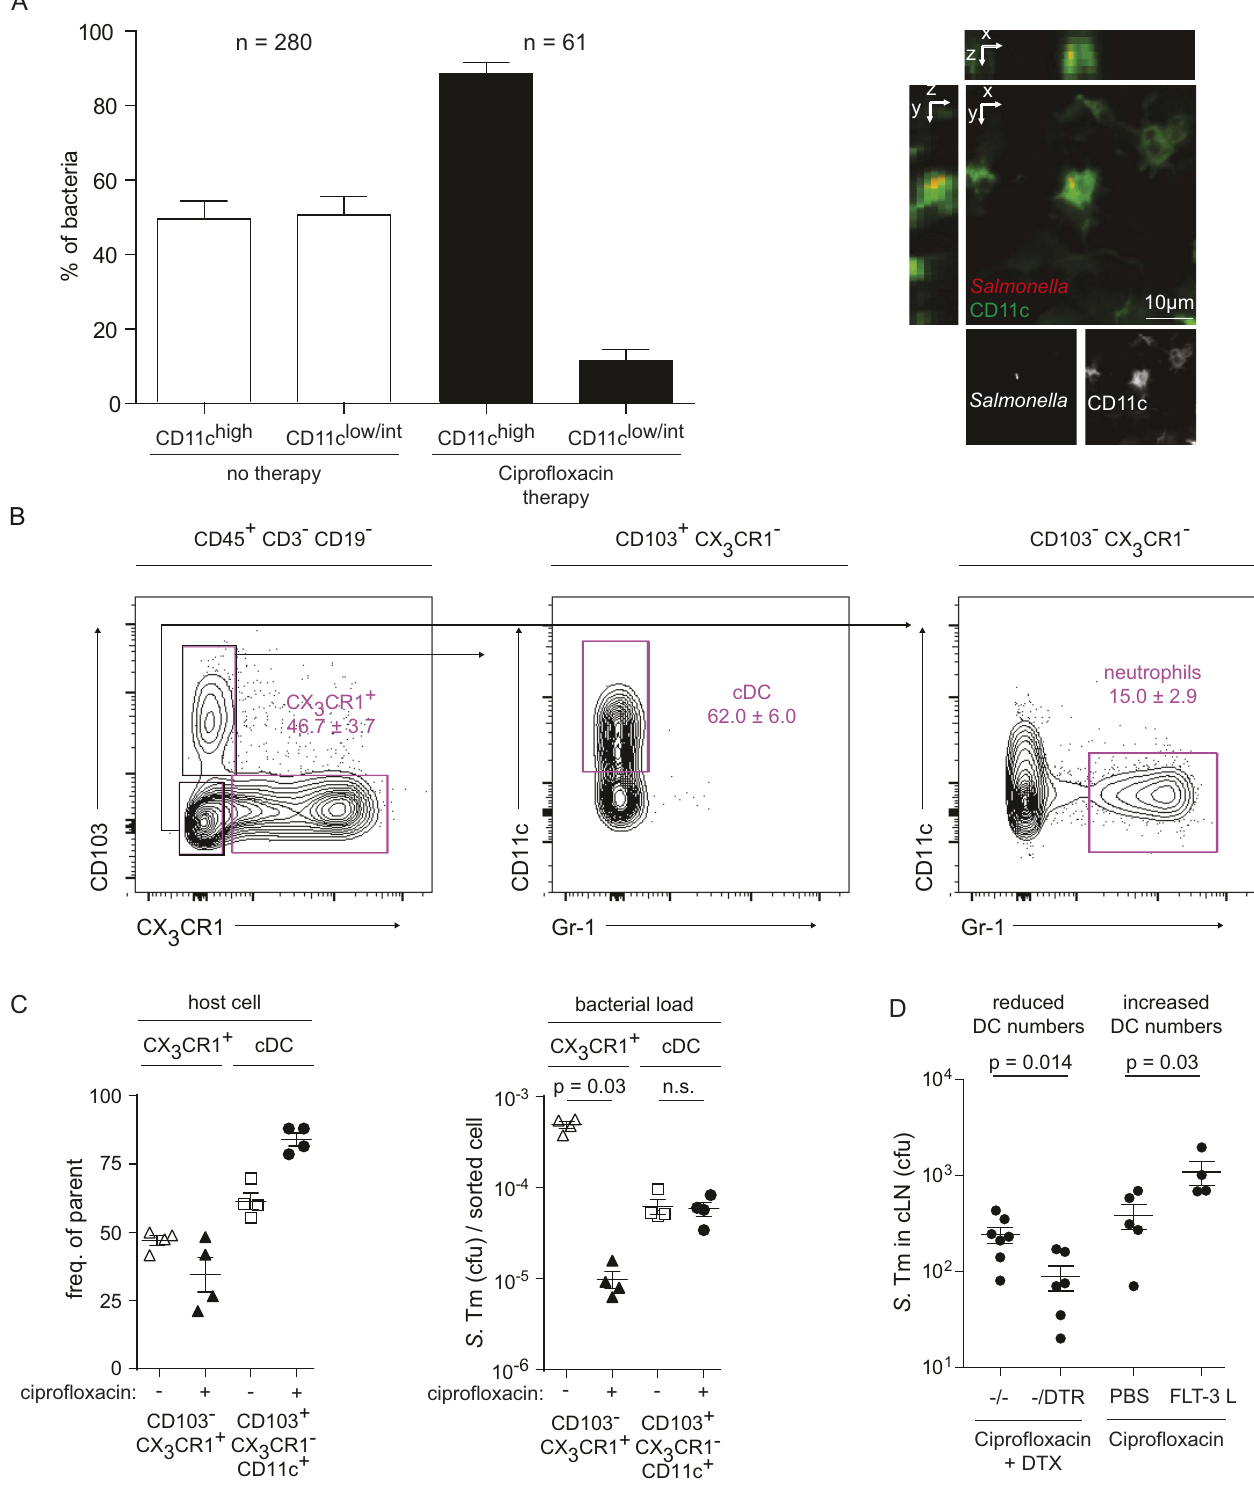
Figure 3. Ciprofloxacin-tolerant bacteria reside within classical CD11c + dendritic cells of the cLN. (A) CD11c-YFP mice were infected with S. Tm pDsRed and subjected to ciprofloxacin therapy (2 6 62 mg/kg/d by gavage; control group was treated with PBS). We prepared 20 m m cryo sections of the cLNs and analyzed them by fluorescence microscopy. Quantification shows accumulation of bacteria within CD11c high cells. (B) Gating approach used for subsequent sorting by flow cytometry. Three nonlymphoid subsets were defined as (1) CX 3 CR1 + iDCs: CD103 2 CX 3 CR1 + , (2) ‘‘classical’’ dendritic cells CD103 + CX 3 CR1 2 CD11c + Gr-1 2 (cDC), and (3) CD103 2 CX 3 CR1 2 CD11c 2 Gr-1 + ‘‘neutrophils.’’ (C) Frequency and respective bacterial load of S. Tm harboring CX 3 CR1 + interstitial and classical DC subsets. Filled symbols, ciprofloxacin therapy; empty symbols, no therapy.